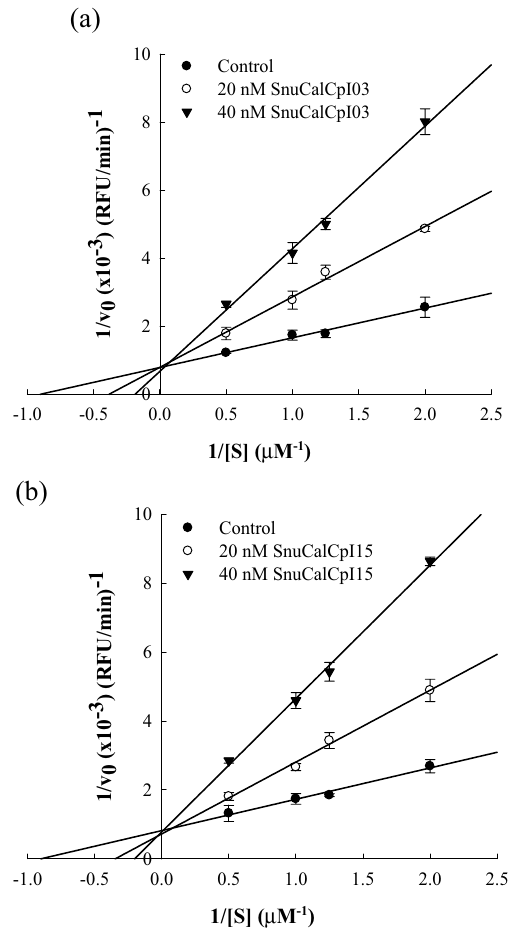
Figure 3. The Lineweaver–Burk plot for the determination of inhibition type ( a ) SnuCalCpI03 and ( b )